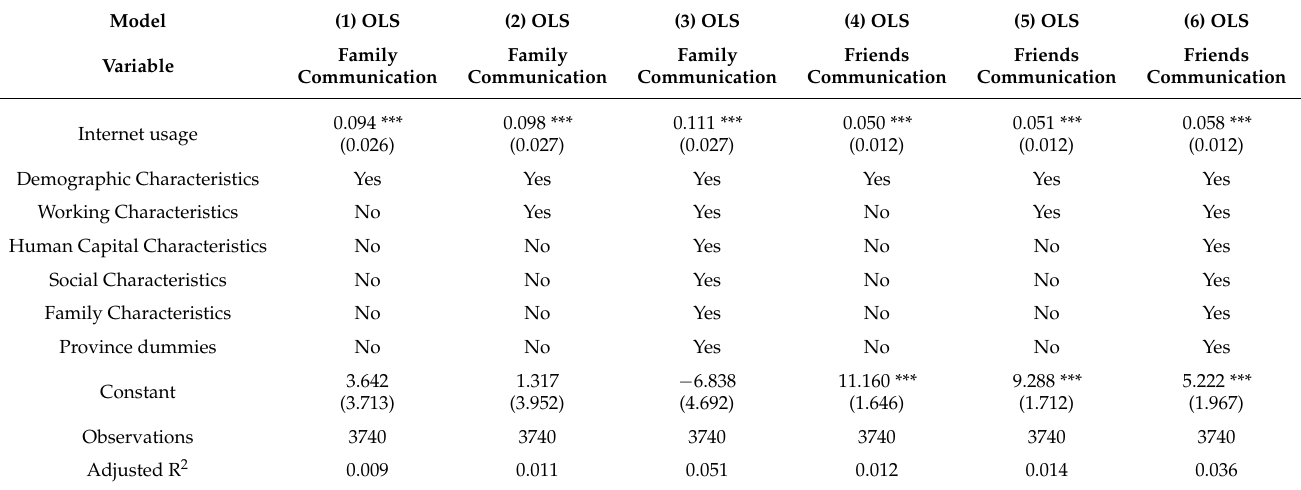
Table 6. Replacing the missing values with the mean of the remaining values (OLS